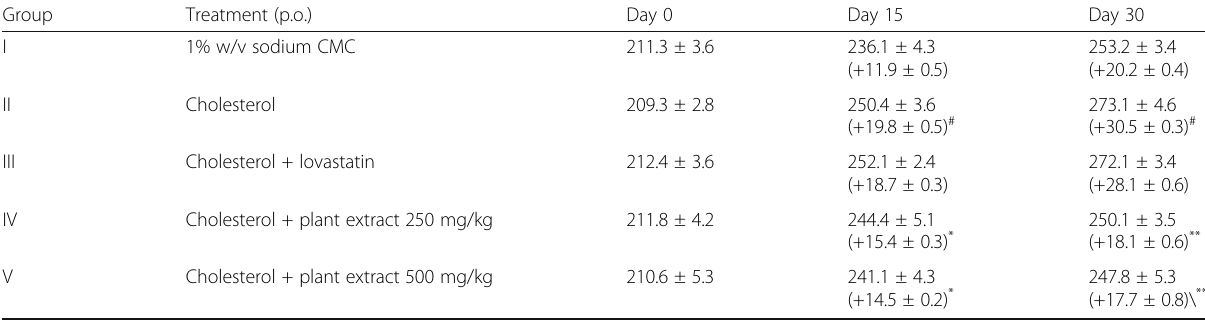
# p < 0.01 vs group I; *, ** p < 0.05 and 0.01 vs cholesterol induced hyperlipidemic control group